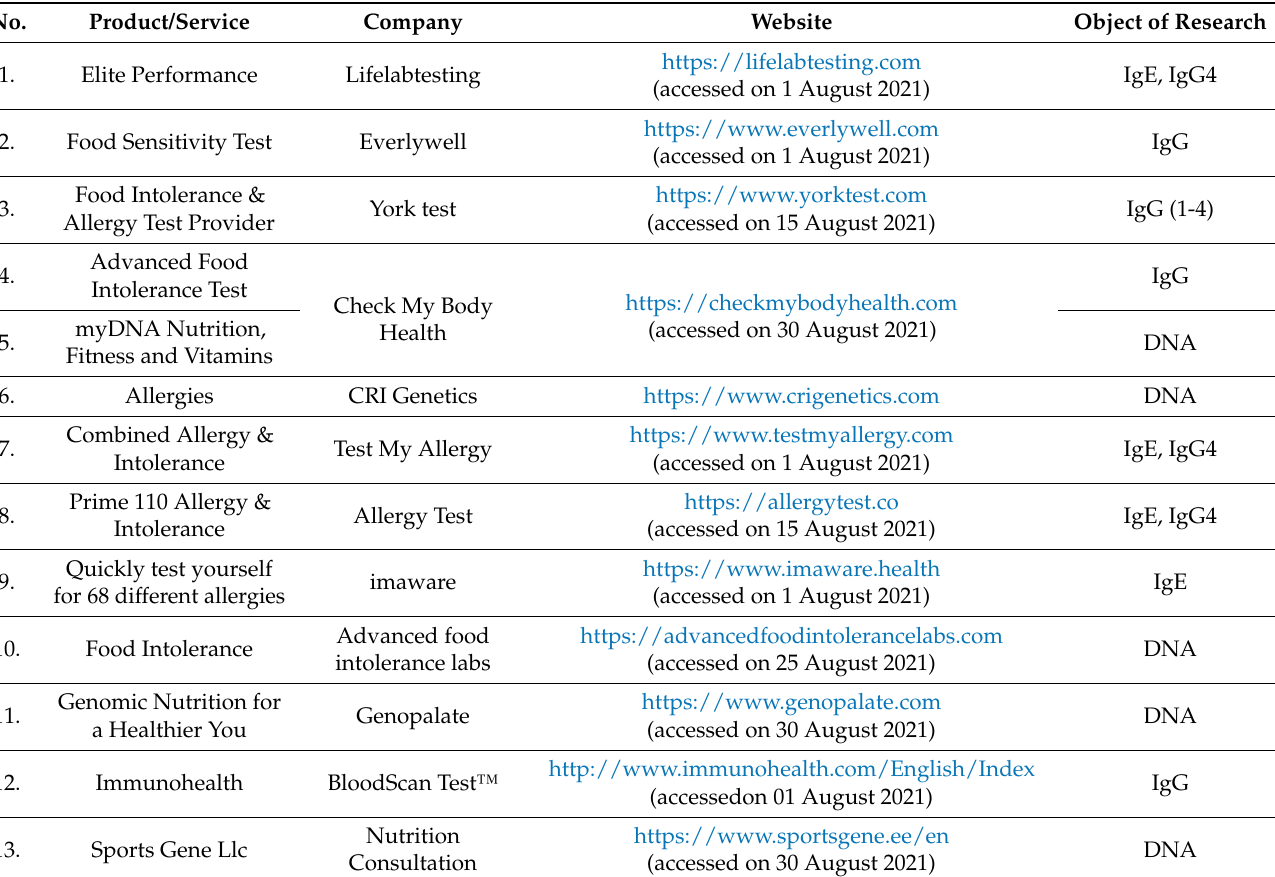
Table 1. List of commercial products for detecting food intolerances or